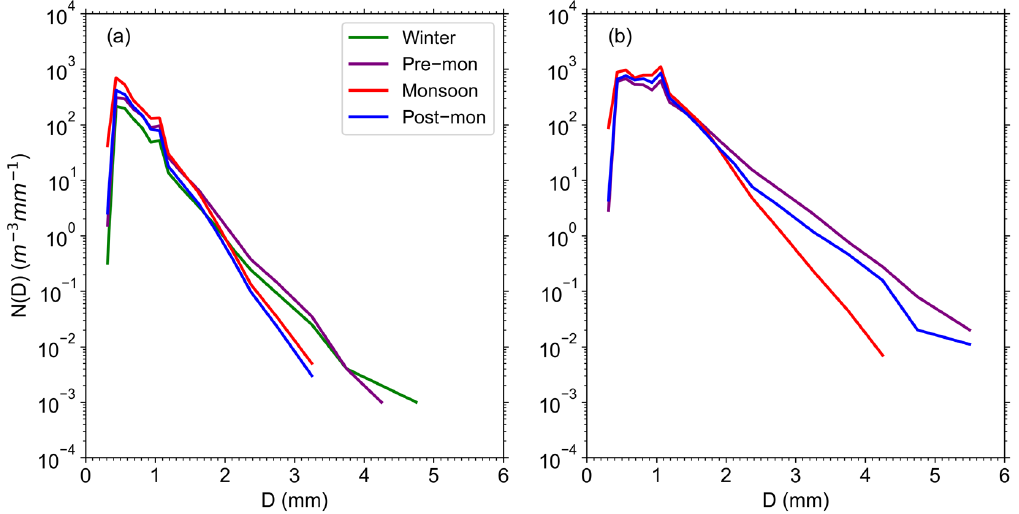
Figure 9. The mean DSDs of stratiform rain ( a ) and convective rain ( b ) for different seasons.